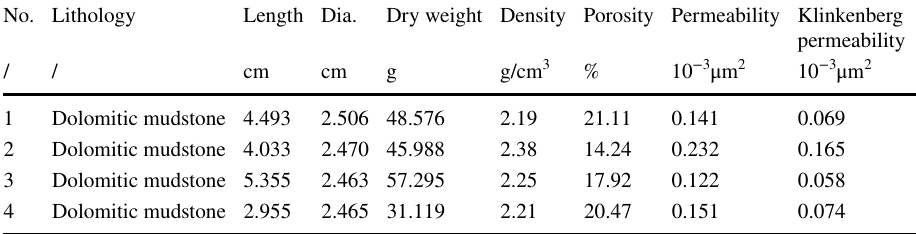
Table 2 Core data and pore